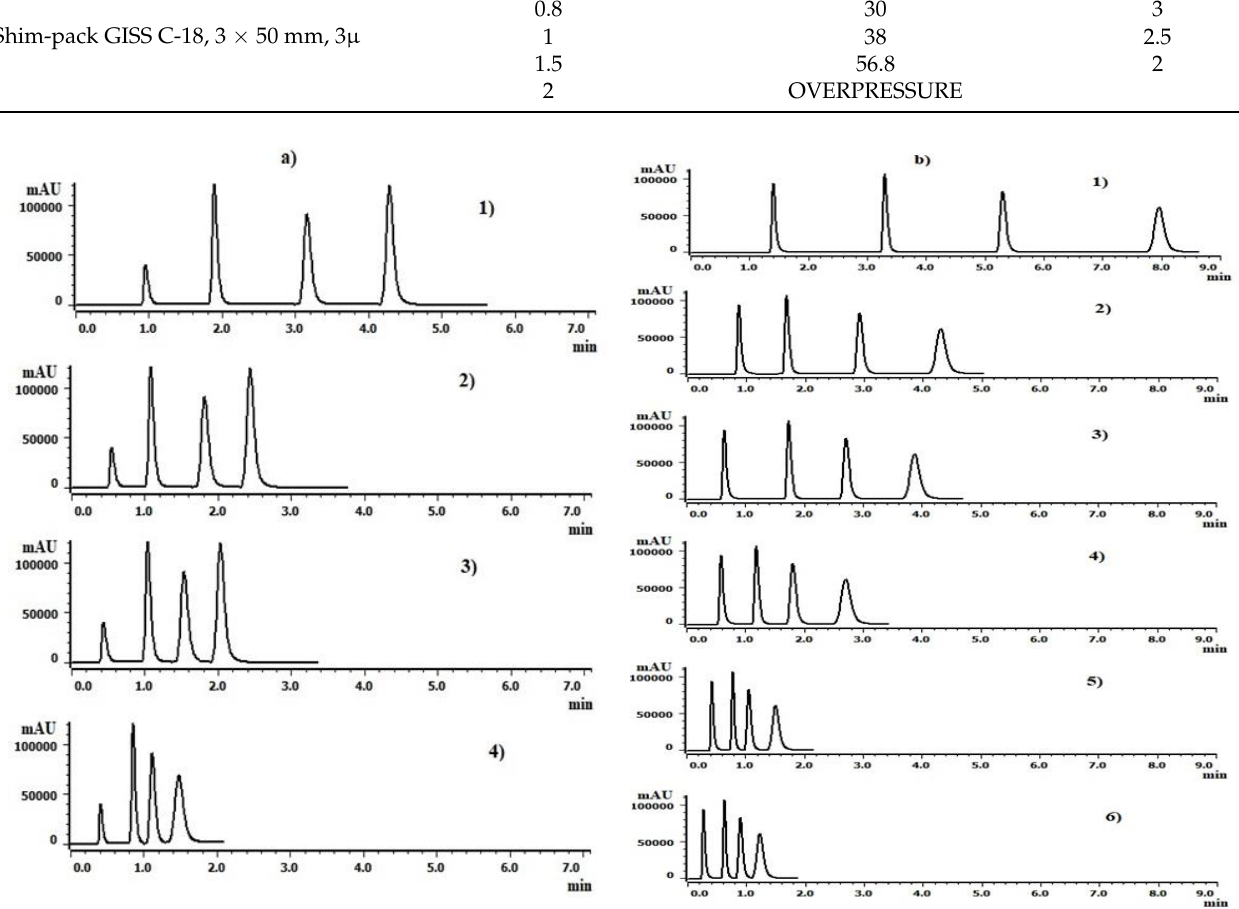
Figure 3. Chromatograms of separation of the compounds by ( a ) UHPLC column with flow rates ( 1 ) 0.5 mL/min, ( 2 ) 0.8 mL/min, ( 3 ) 1 mL/min, ( 4 ) 1.5 mL/min, and ( b ) monolithic column with flow rates ( 1 ) 0.5 mL/min, ( 2 ) 0.8 mL/min, ( 3 ) 1 mL/min, ( 4 ) 1.5 mL/min, ( 5 ) 3 mL/min, and ( 6 ) 5 mL/min.